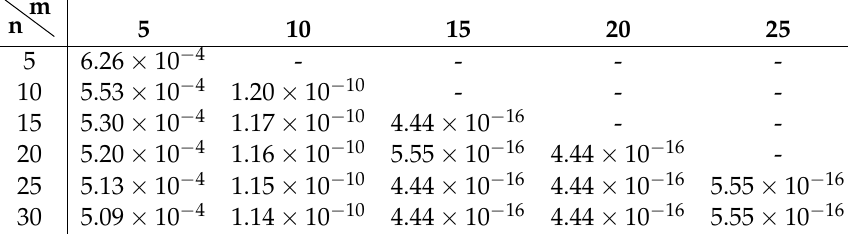
Table 3. Maximum test set solution error using Legendre polynomials for Problem #